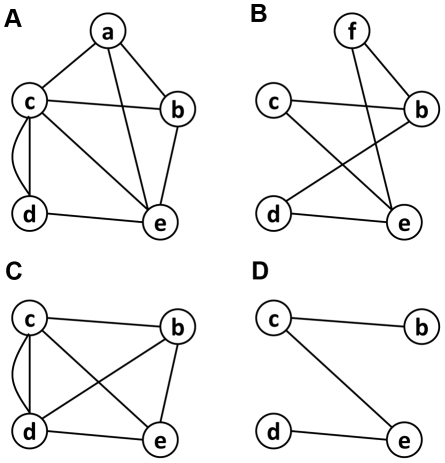
An example illustrating the graph alignment algorithm we utilized.